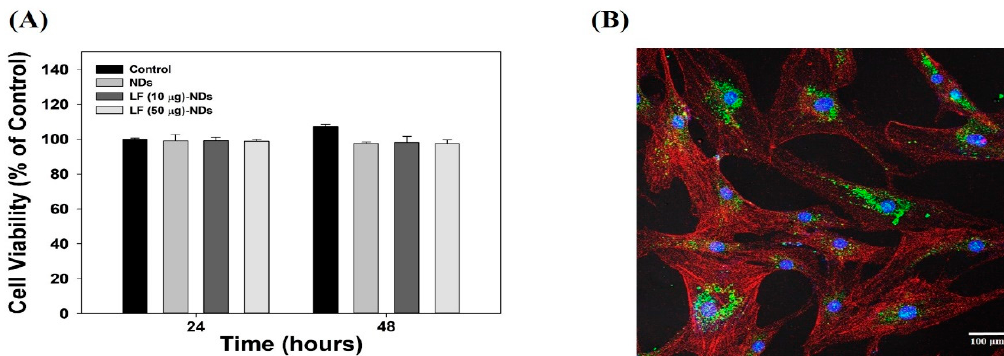
Figure 4. ( A ) Cytotoxicity test of NDs, LF (10 μ g)-NDs and LF (50 μ g)-NDs against MC3T3-E1 cells for 24 and 48 h; ( B ) In vitro cellular internalization of FITC-NDs after incubation of 4 h. Scale bar: 100 μ m.